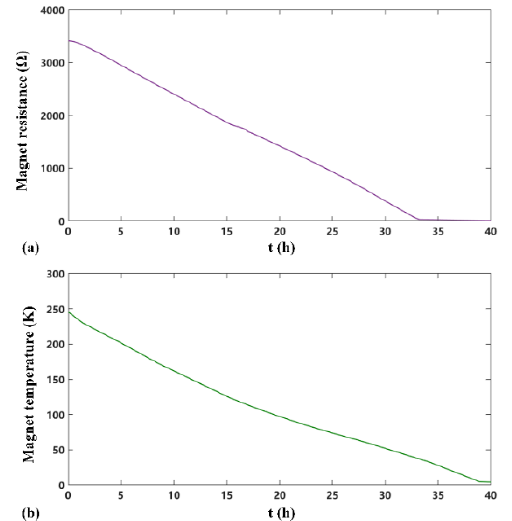
Fig. 5. Internal structure of